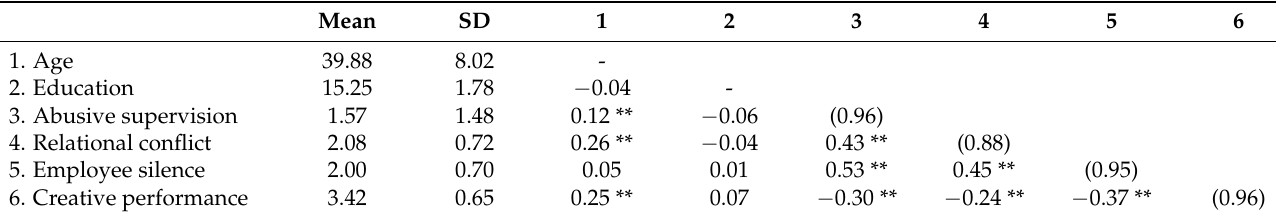
Table 1. Descriptive Statistics and Inter-correlations.